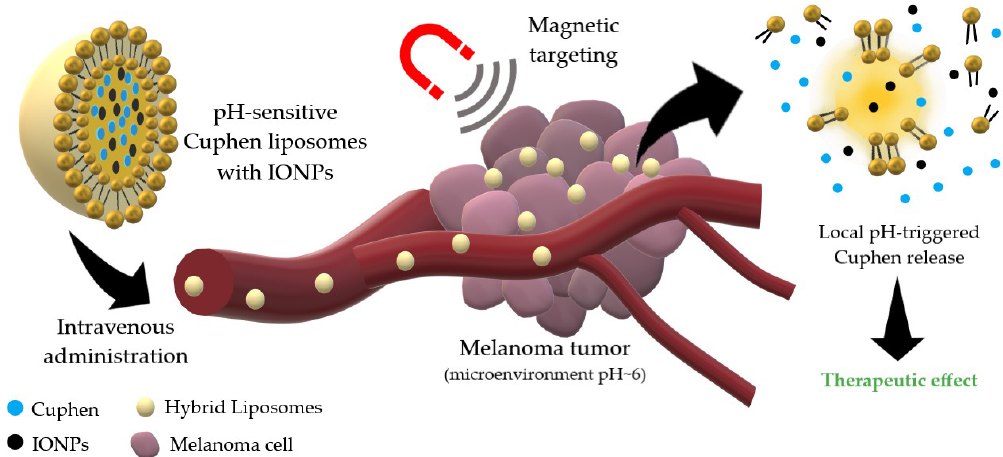
Figure 1. Schematic representation of the hybrid nanosystem integrating cytotoxic and magnetic properties as a tool to potentiate melanoma therapy.